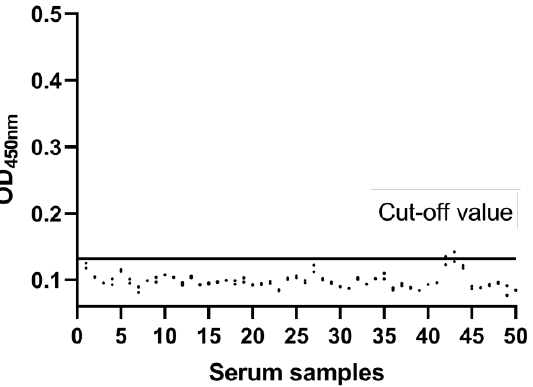
Figure 5. Determination of the cut-off value of the DAgS-ELISA (OD450nm = 0.132).